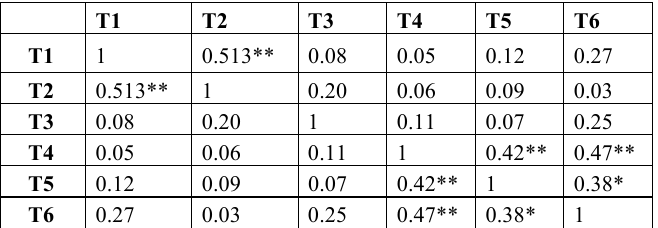
Table 8. Correlation analysis for the advanced syllabus (* p<0.05, **